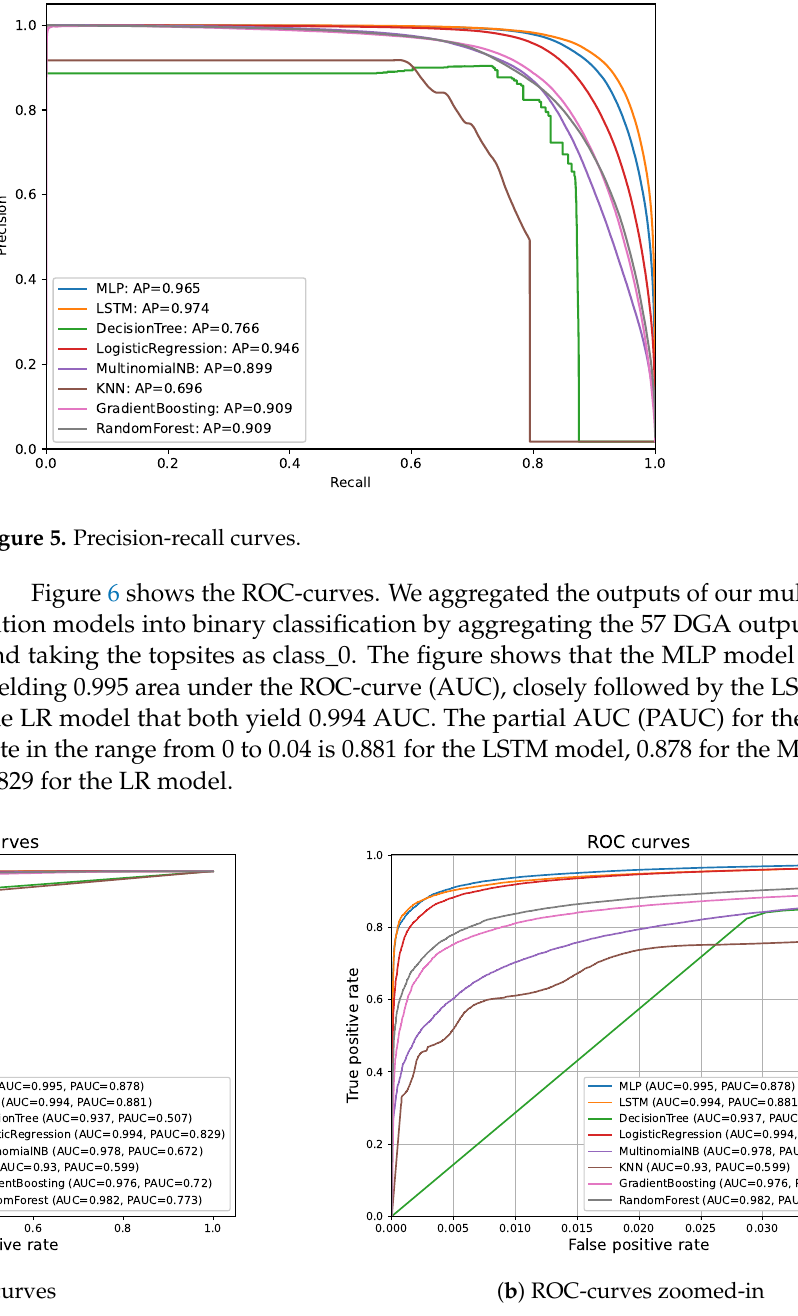
Figure 6. ROC-curves. Table 10 shows the optimum true positive and false positive rate for each model. The MLP model yields best results (96.54% TPR and 2.53% FPR) and performs slightly better than the LR model (96.11% TPR and 3.13% FPR) and the LSTM model (95.67% TPR and 2.68%